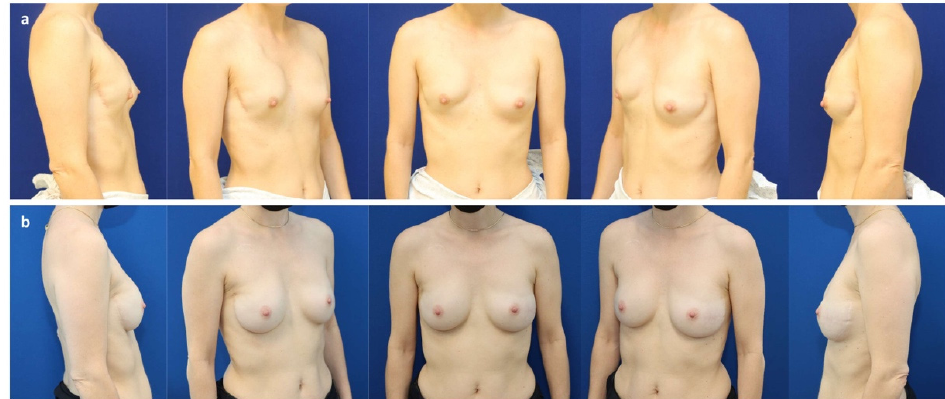
Figure 2. ( a ) A 45-year-old patient after a bilateral nipple-sparing mastectomy through a lateral access for invasive-ductal carcinoma (pT2 pN0 M0) of the right breast and a prophylactic mastectomy of the left breast after immediate subpectoral implant-based reconstruction elsewhere. Note the capsular contraction grade IV (Baker classification) and implant displacement on the right. ( b ) Six years after bilateral partial capsulectomy, reconstruction of the subpectoral implant pocket using a resorbable synthetic mesh (Vicryl ® , Ethicon, Cincinnati, OH, USA), and implant exchange (Motiva Ergonomix ® ERSD 300 cc).